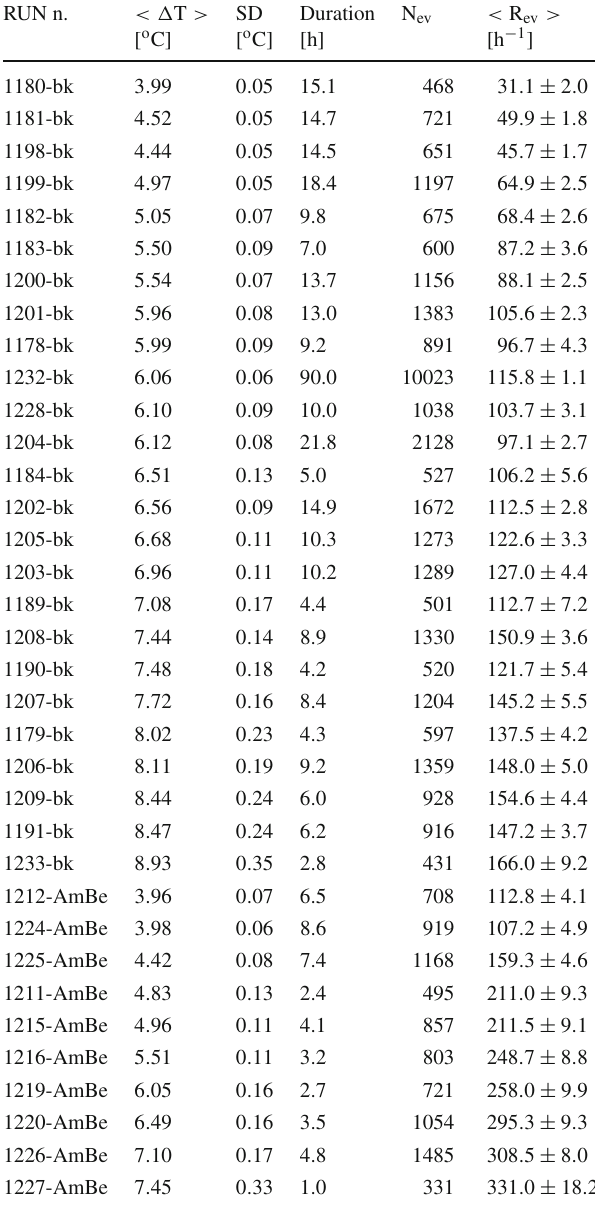
Table 1 MOSCAB data taking above ground in the Milano Bicocca INFN Laboratory at T L = 25 ◦ C RUN